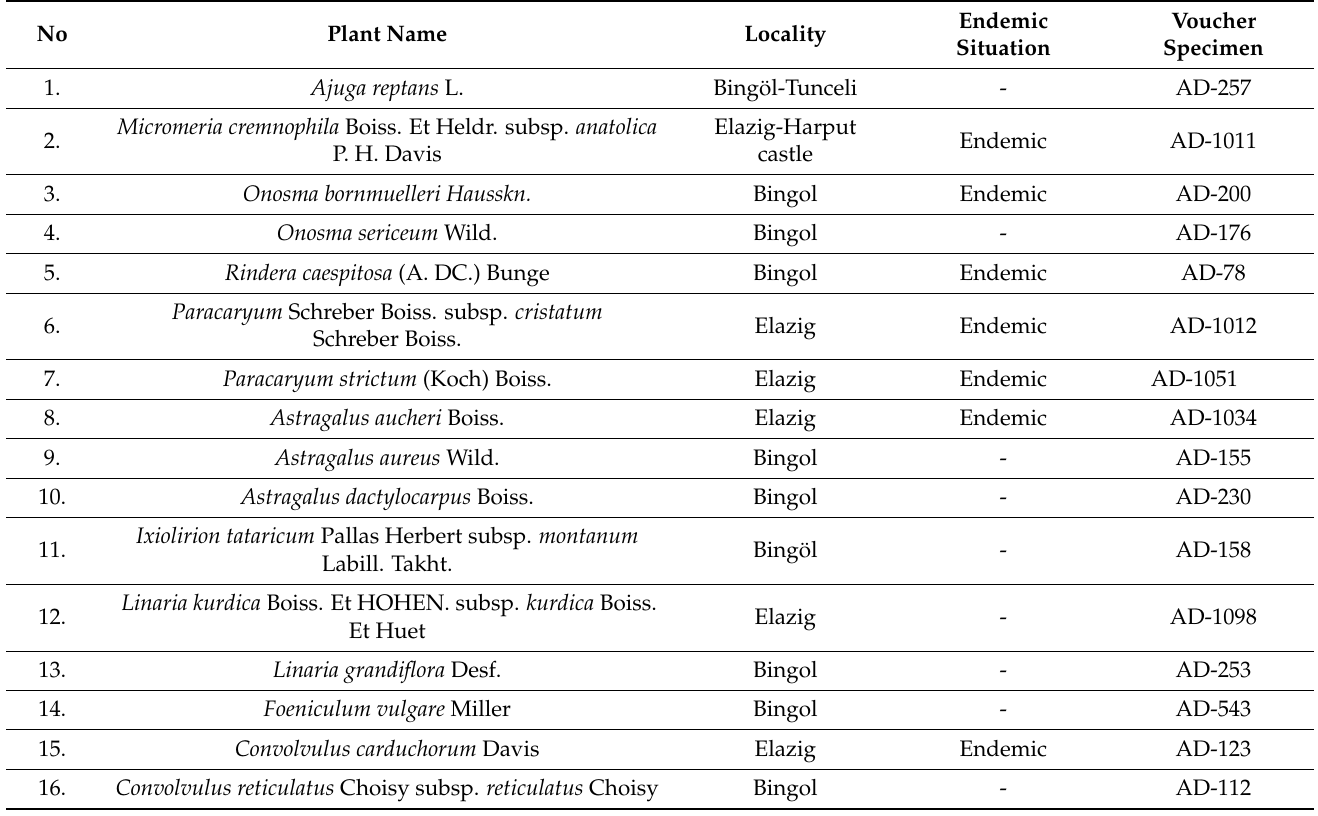
Table 1. Plant sampling, vouchering, and endemism.